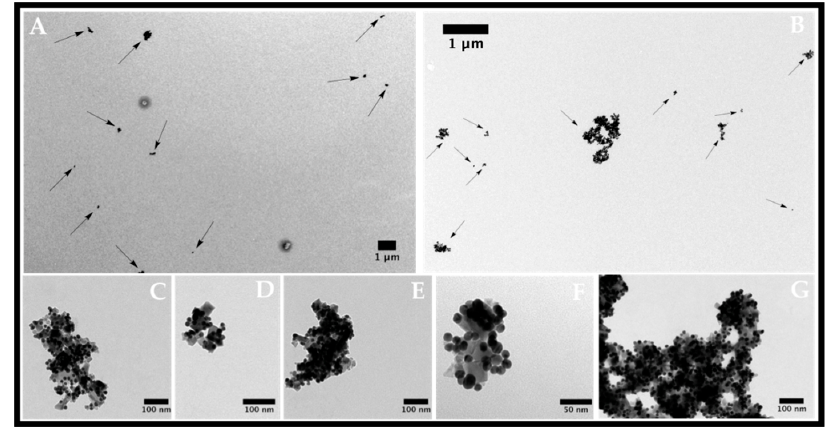
Figure 3. Transmission electron micrographs of strawberry Fe/Au nanomaterials functionalized with oligo(2-ethyl-2-oxazoline) in different magnifications. ( A , B ) magnetite nanoparticles; ( C – G ) Strawberry-like gold magnetite nanocomposites functionalized with oligo(2-ethyl-2-oxazoline).